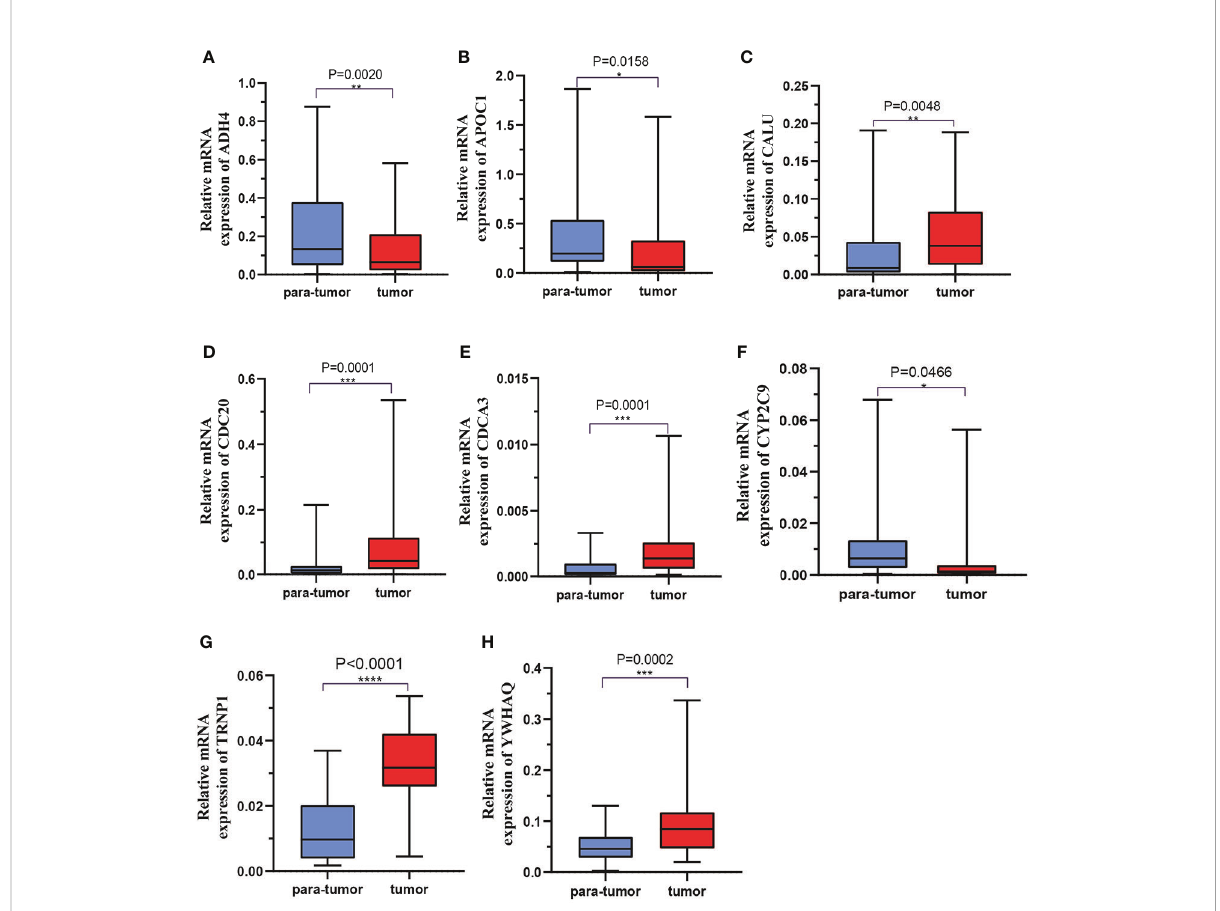
FIGURE 11 The mRNA expression levels of 8 DMRegs of prognostic signature in hepatocellular carcinoma tissues and corresponding normal tissues by